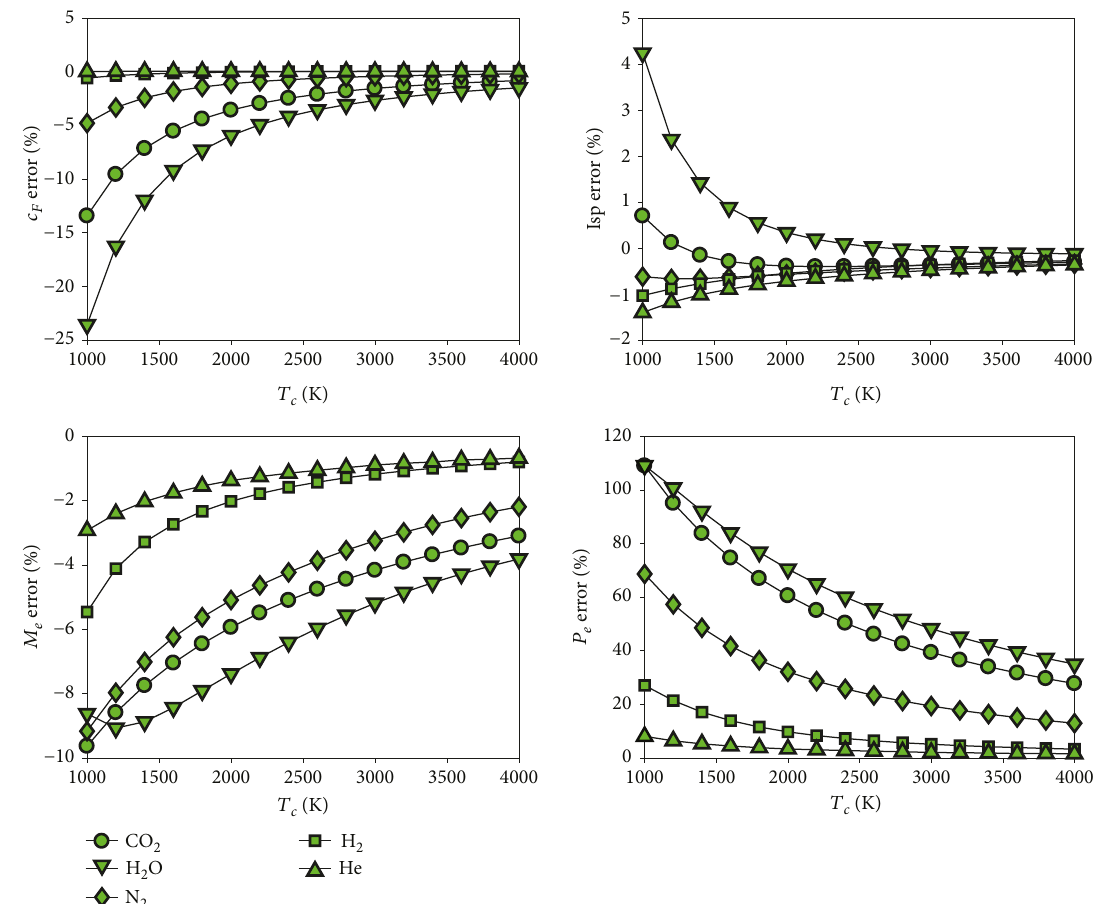
Figure 4: Errors of propulsion parameters and fl ow parameters of thermally perfect ideal gases with respect to VDW gases at di ff erent chamber temperatures, for vacuum expansion, A